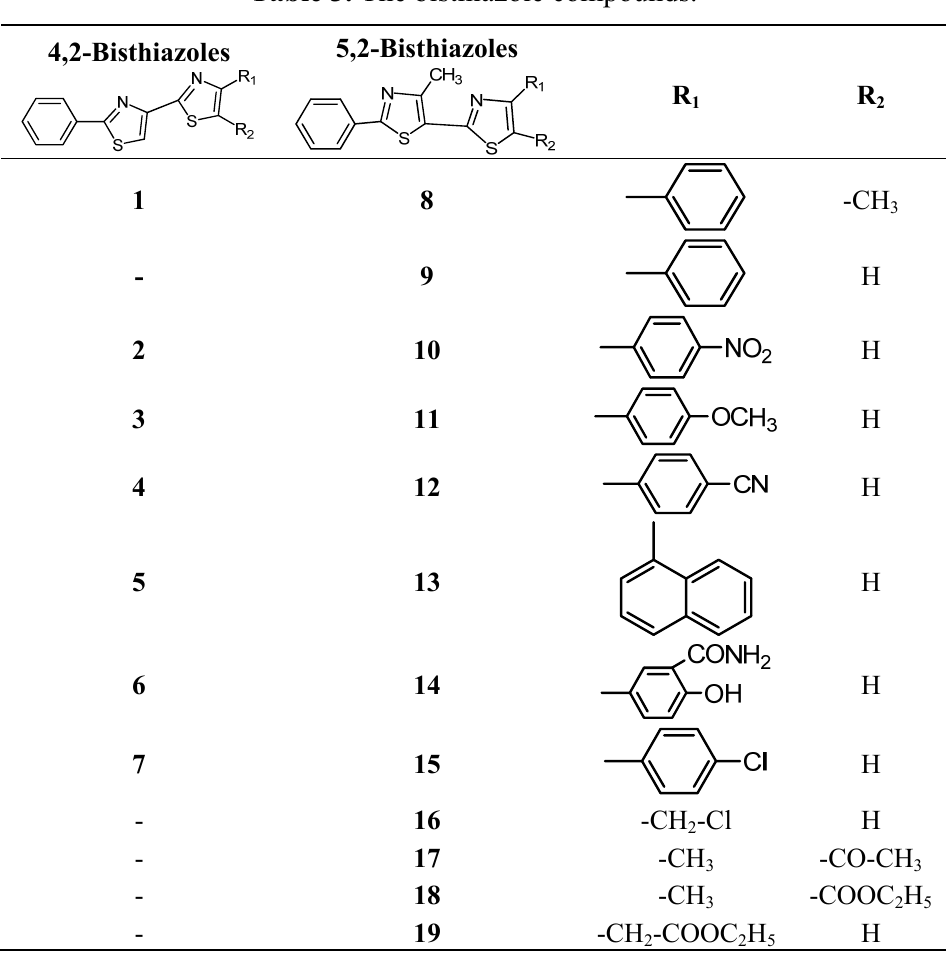
Table 3. The bisthiazole